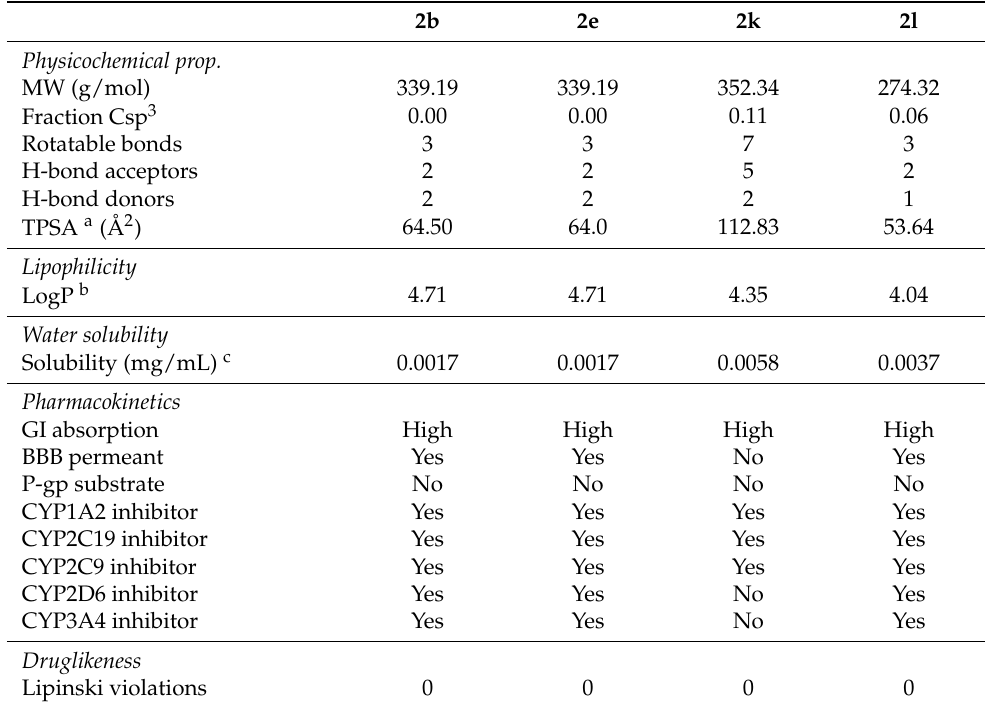
Table 2. Predicted pharmacokinetics and drug-like properties of anilino pyrazoles 2b , e , k , l. 2b 2e 2k 2l Physicochemical